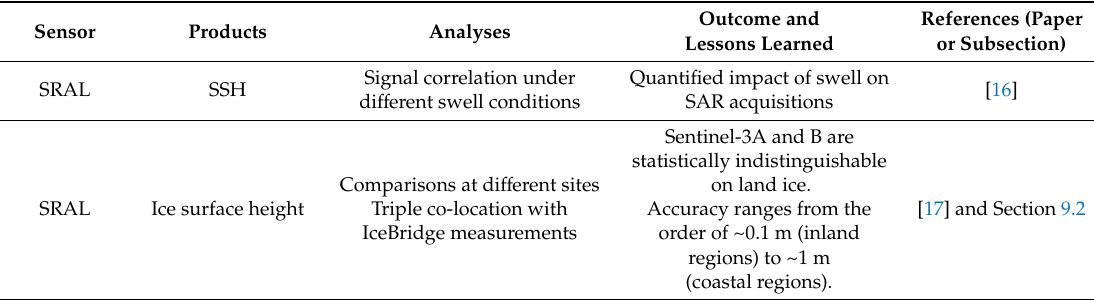
Table 1. Overview of the Sentinel-3 tandem for climate